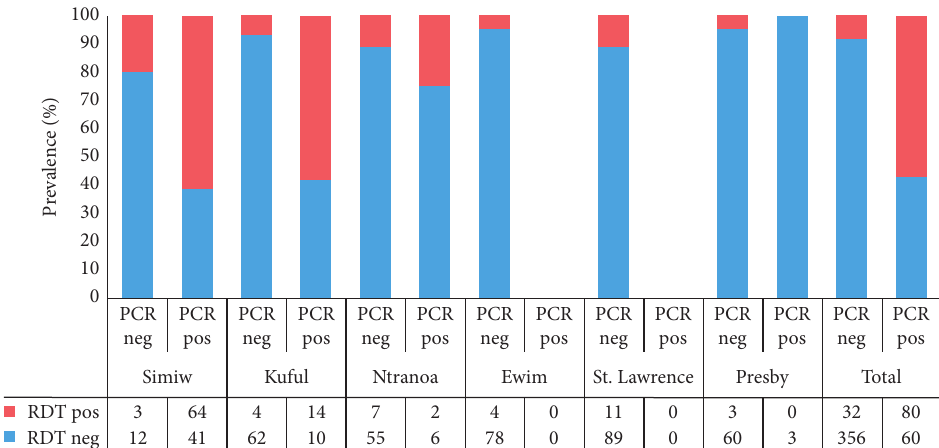
Figure 3: Site-specific sensitivity and specificity of the RDT. A bar graph representing the specificity and sensitivity of the RDT results relative to P. falciparum PCR. PCR neg, sample tested negative by PCR; PCR pos, sample tested positive by PCR; RDT neg, sample tested negative by rapid diagnostic test (HRP2); RDTpos, sample tested positive by rapid diagnostic test (HRP2); PCR, polymerase chain reaction. The data in the table represent exact counts.